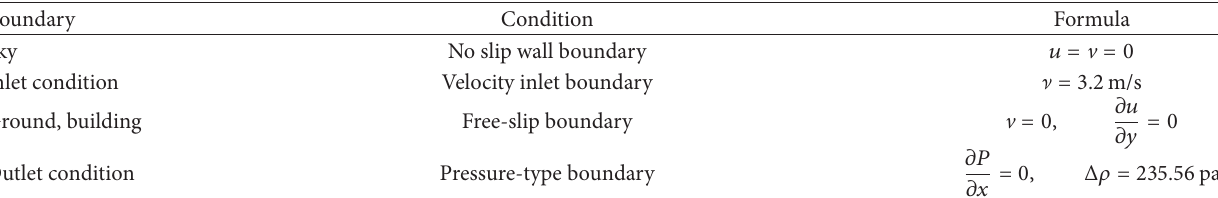
Table 1: Boundary conditions.